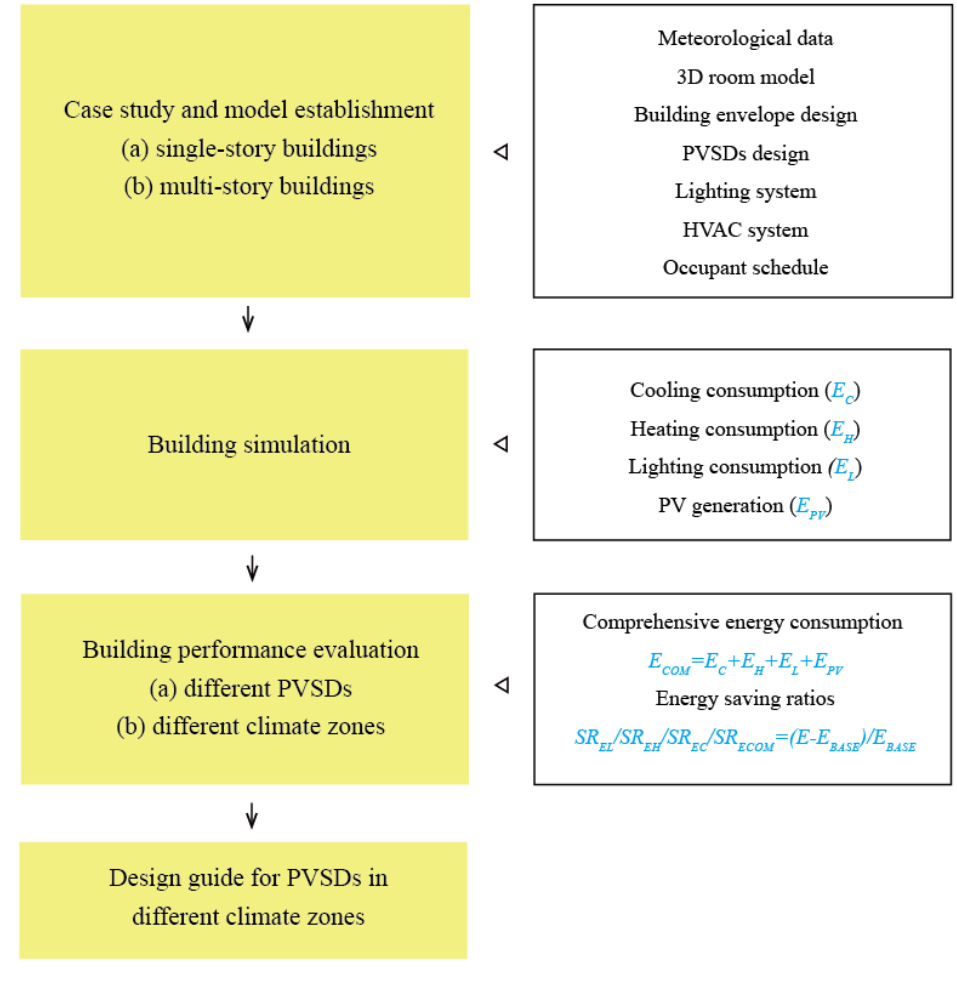
Figure 5. Research framework.